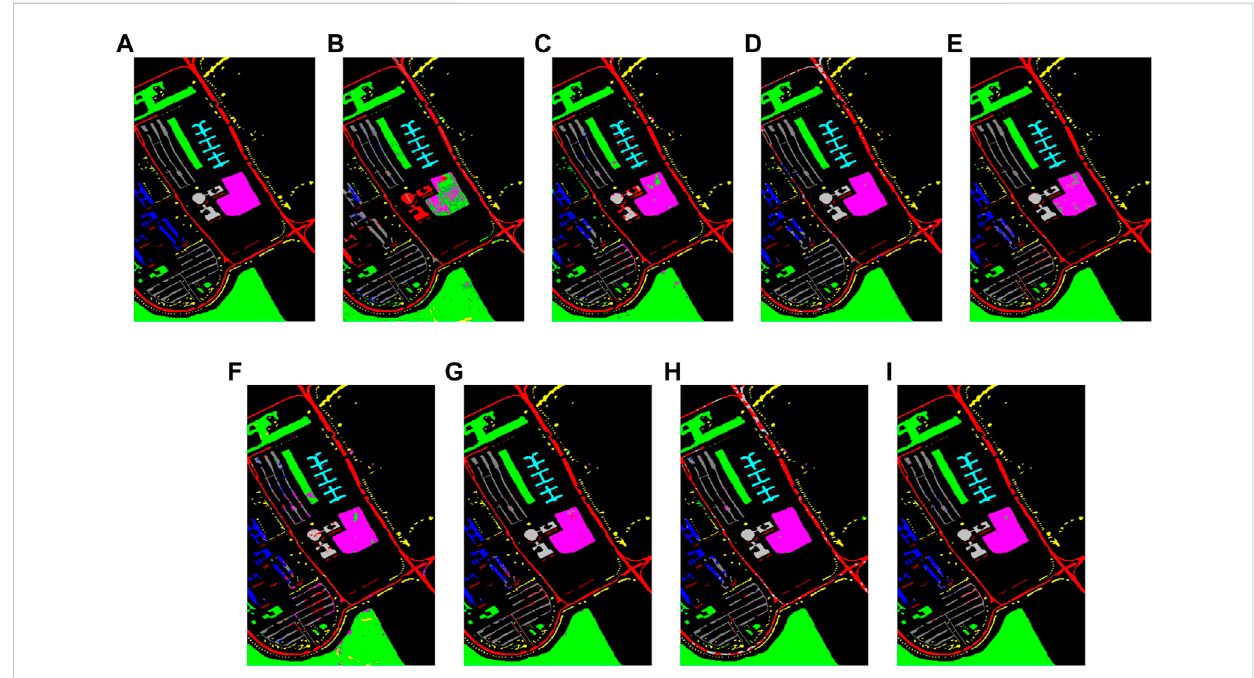
FIGURE 4 Classi fi cation results of the Pavia University dataset. (A) Ground-truth map, (B) EMP-SVM, (C) SSRN, (D) ResNet, (E) PyResNet, (F) CNAS, (G) MLP- Mixer, (H) ANAS-CPA-LS, and (I) CK- β NAS-CLR.